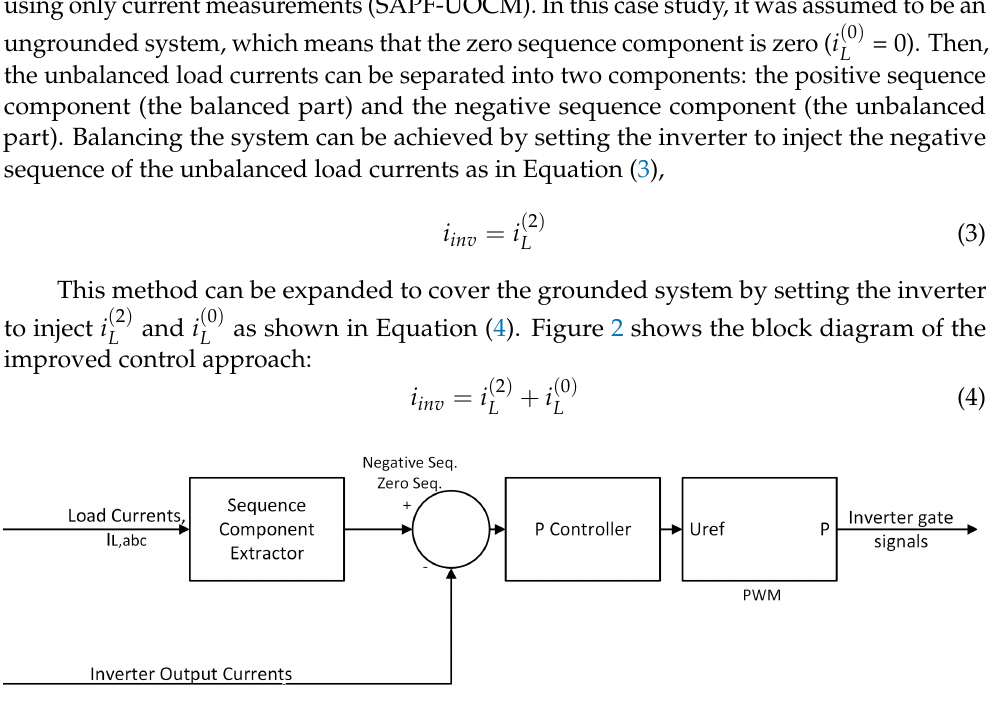
Figure 2. The control block diagram of the improved SAPF-UOCM